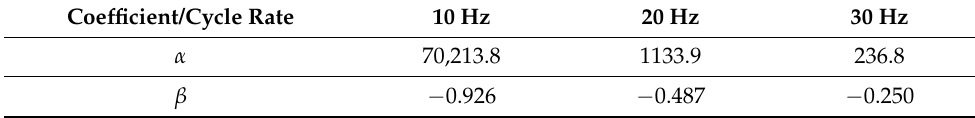
Table 6. Calculated values of α and β for the ABS material and the given cycle rates.